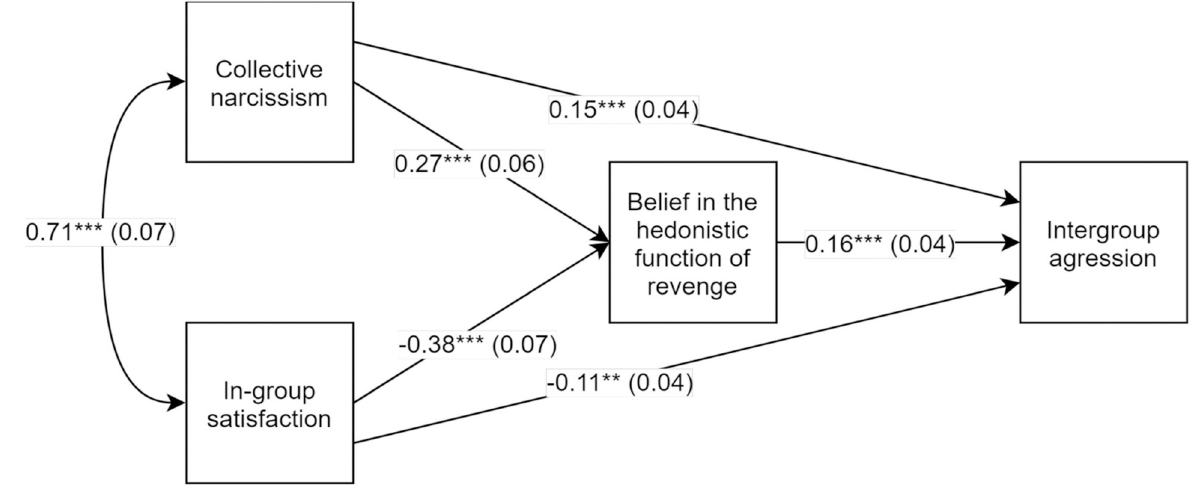
Fig 1. Unstandardized path coefficients, Study 1. �� p < .01; ��� p < .001.